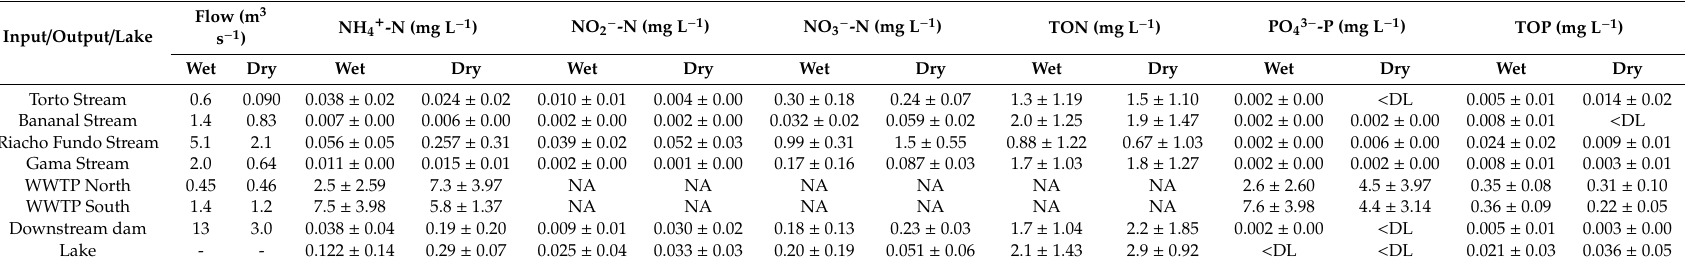
Table 1. Mean flows, mean concentrations and standard deviations of nitrogen and phosphorus in the streams (input), e ffl uent from WWTPs (input), downstream dam (output) and lake for the wet and dry